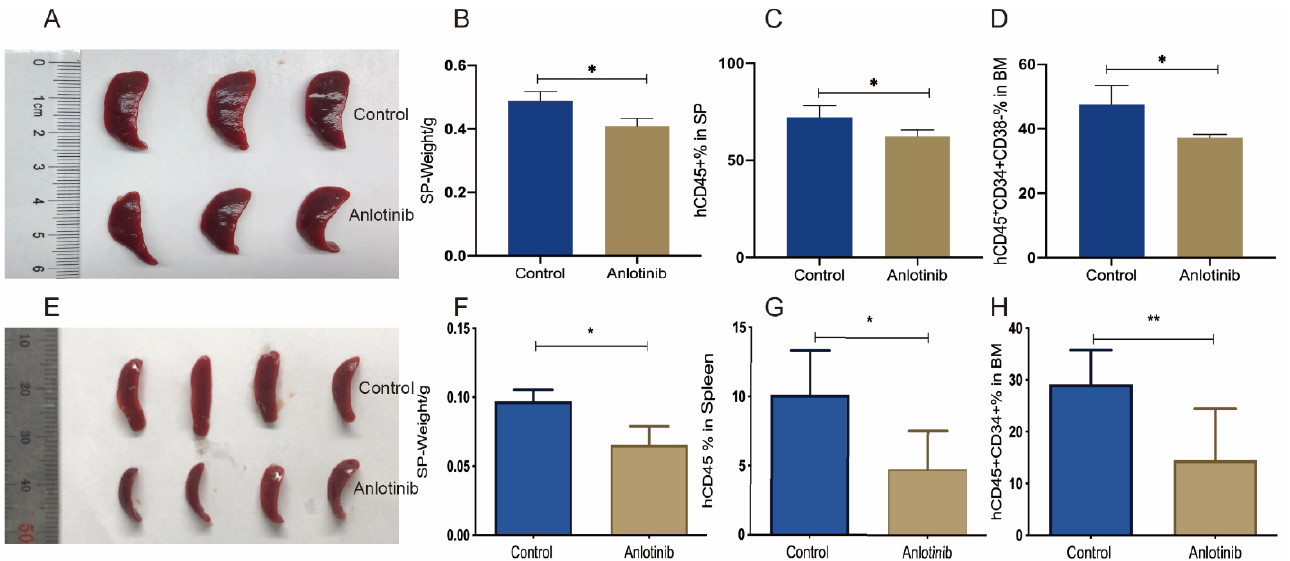
Figure 3. Efficacy of anlotinib in inhibiting regeneration of LSCs in PDX models. ( A – D ) Efficacy of anlotinib in impairing the regeneration capacity of CD34 + CD38 - LSCs in patient-derived leukemia xenograft mice model. The spleen size ( A ) and weight ( B ) and the percentages of hCD45 + cell in the spleen ( C ) and the percentages of CD45 + CD34 + cells in bone marrow ( D , n = 3/group). ( E – H ) Efficacy of anlotinib in impairing the regeneration capacity of CD34 + LSCs in patient-derived leukemia xenograft mice model. The spleen size ( E ) and weight ( F ) and the percentage of hCD45 + cell in the spleen ( G ) a and the percentage of CD45 + CD34 + cells in bone marrow ( H , n = 4/group). * p < 0.05, ** p < 0.01.